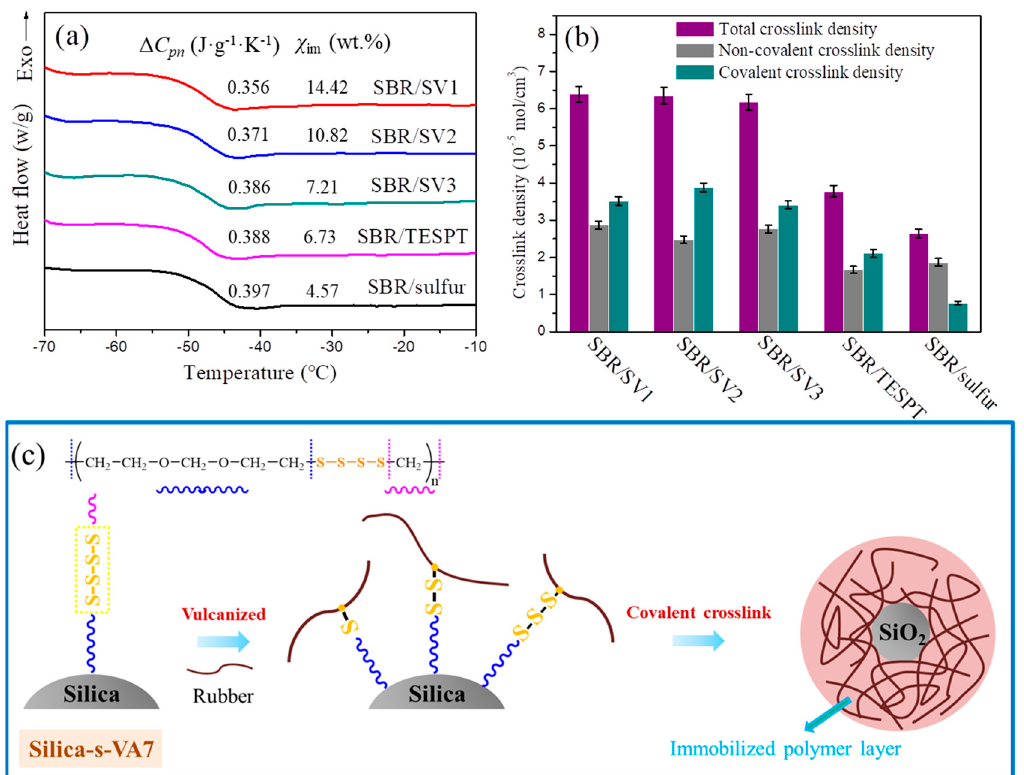
Figure 6. ( a ) DSC curves of SBR/silica nanocomposites at the glass-transition region, ( b ) crosslinking density of SBR/silica nanocmoposites, and ( c ) interfacial reaction in SBR/silica-s-VA7 composites during vulcanization.